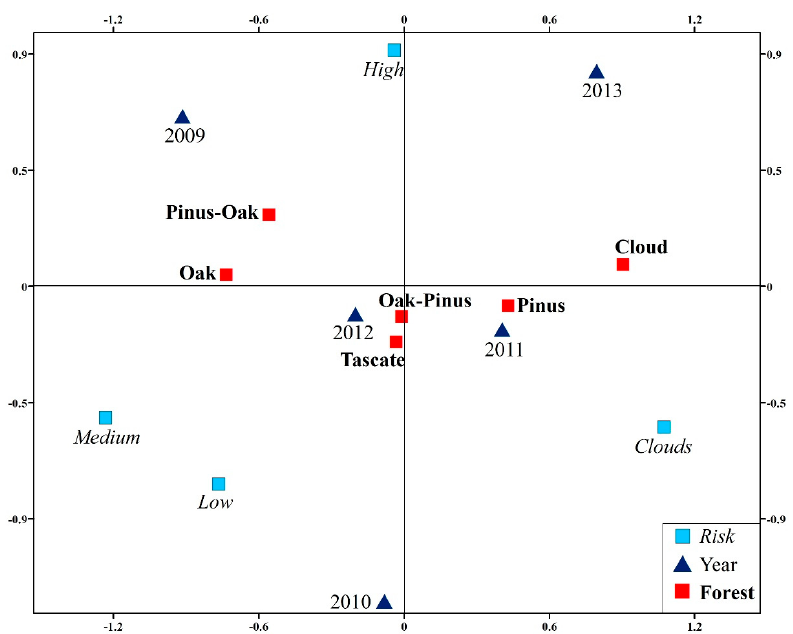
Figure 5. Association of three risk categories of fuel load and clouds (blue squares), type of temperate forest (red diamonds) and year (blue navy triangles).